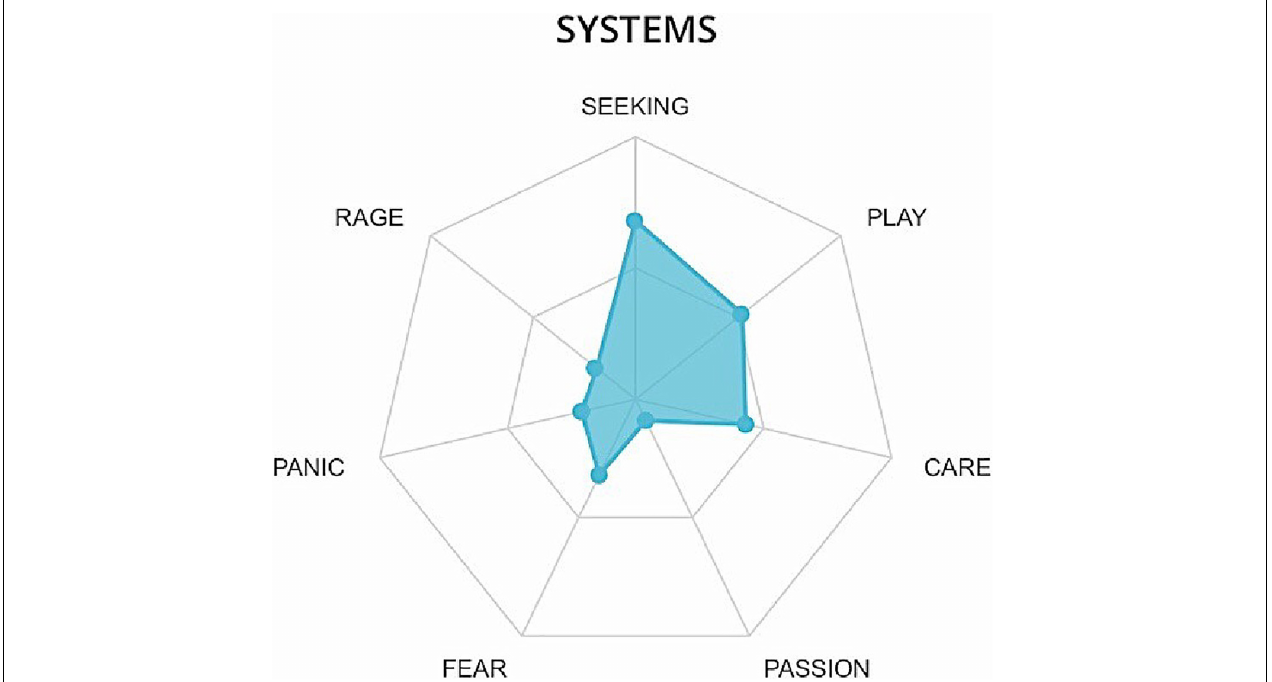
FIGURE 4 | Cumulative web graph relating to all